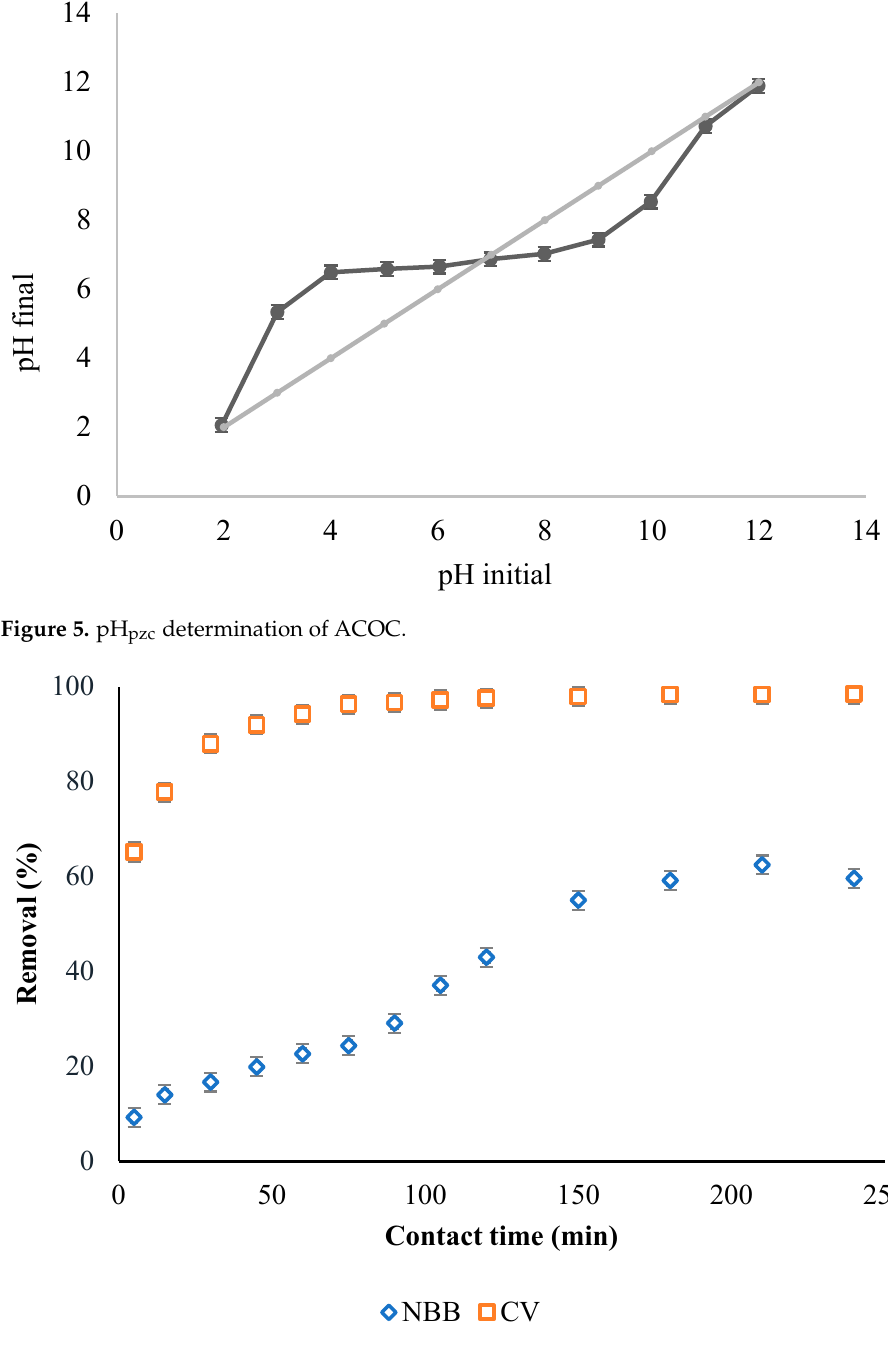
ACOC NBB CV Figure 4. XRD spectra of ACOC before adsorption and after adsorption of NBB and CV.